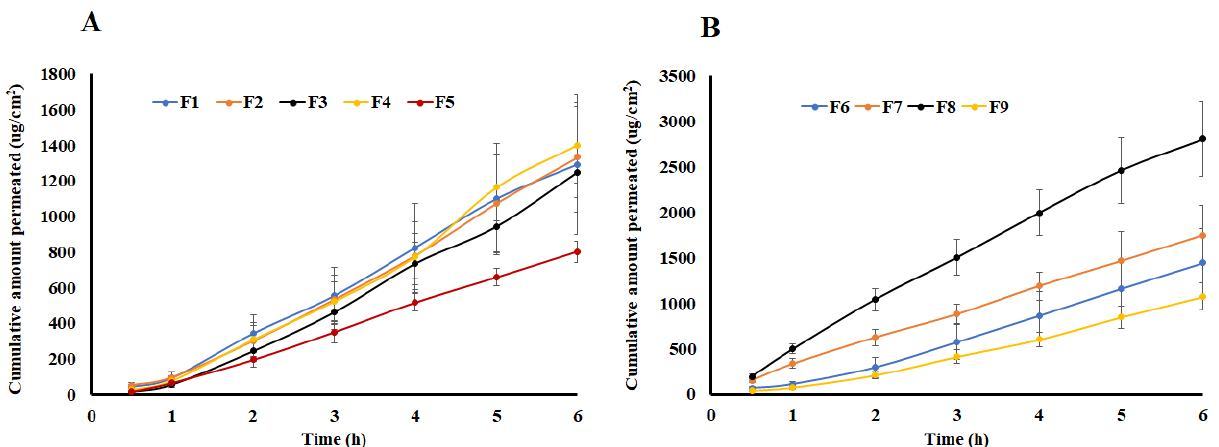
Figure 6. ( A ) Permeation of transdermal gel formulations F1, F2, F3, F4, and F5 through pig ear skin. ( B ) Permeation of transdermal gel formulations F6, F7, F8, and F9 through pig ear skin. Data are shown as mean ± SD, n = 6.